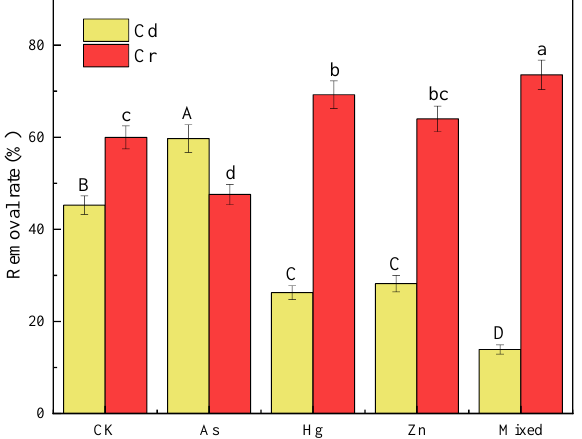
Figure 6. Effects of types of heavy metals on the removal rates of Cr(VI) and Cd(II) in binary systems. Different letters on bars indicate significant differences at p < 0.05 within the same heavy metal (Cd(II) or Cr(VI)) treatments.